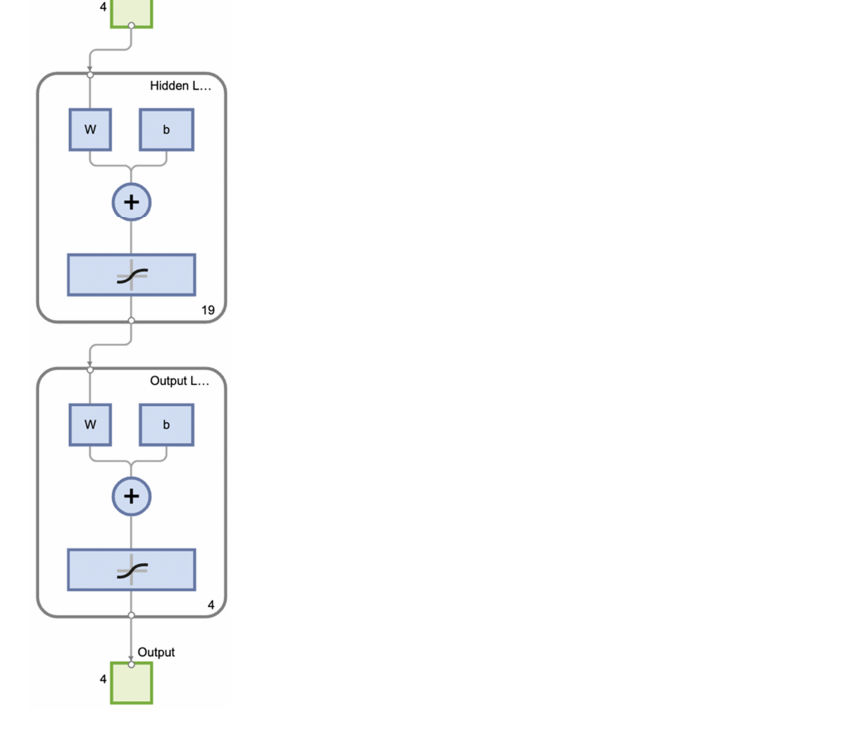
Figure 1. Determination of the node number of the input layer and the output layer. The data were divided into training and test sets by 64 sets and brought into MATLAB 2021 for manipulation. The BP neural network algorithm was used to predict the bond strength of wood after heat treatment.